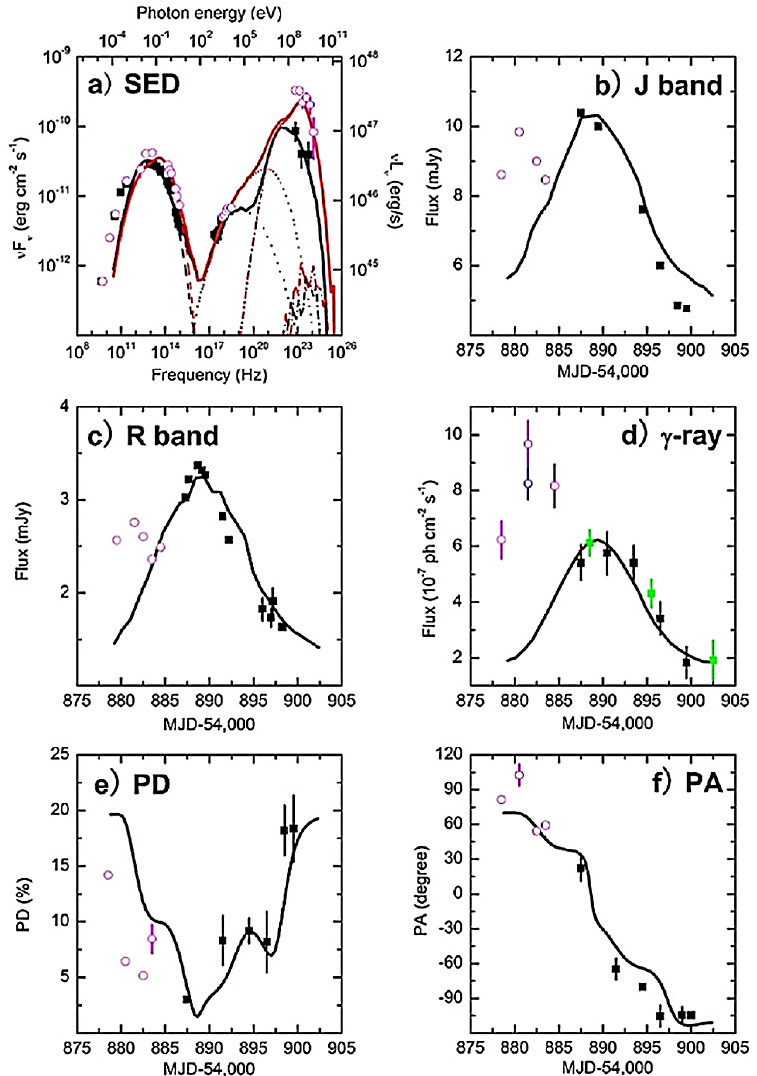
Figure 4. The multiwavelength flare + position angle (PA) swing event of 3C279 in 2009 [14]: Simultaneous fits to ( a ) snap-shot SEDs; ( b – d ) multi-wavelength light curves; and ( e , f ) time-dependent optical polarization characteristics. PD: polarization degree. From